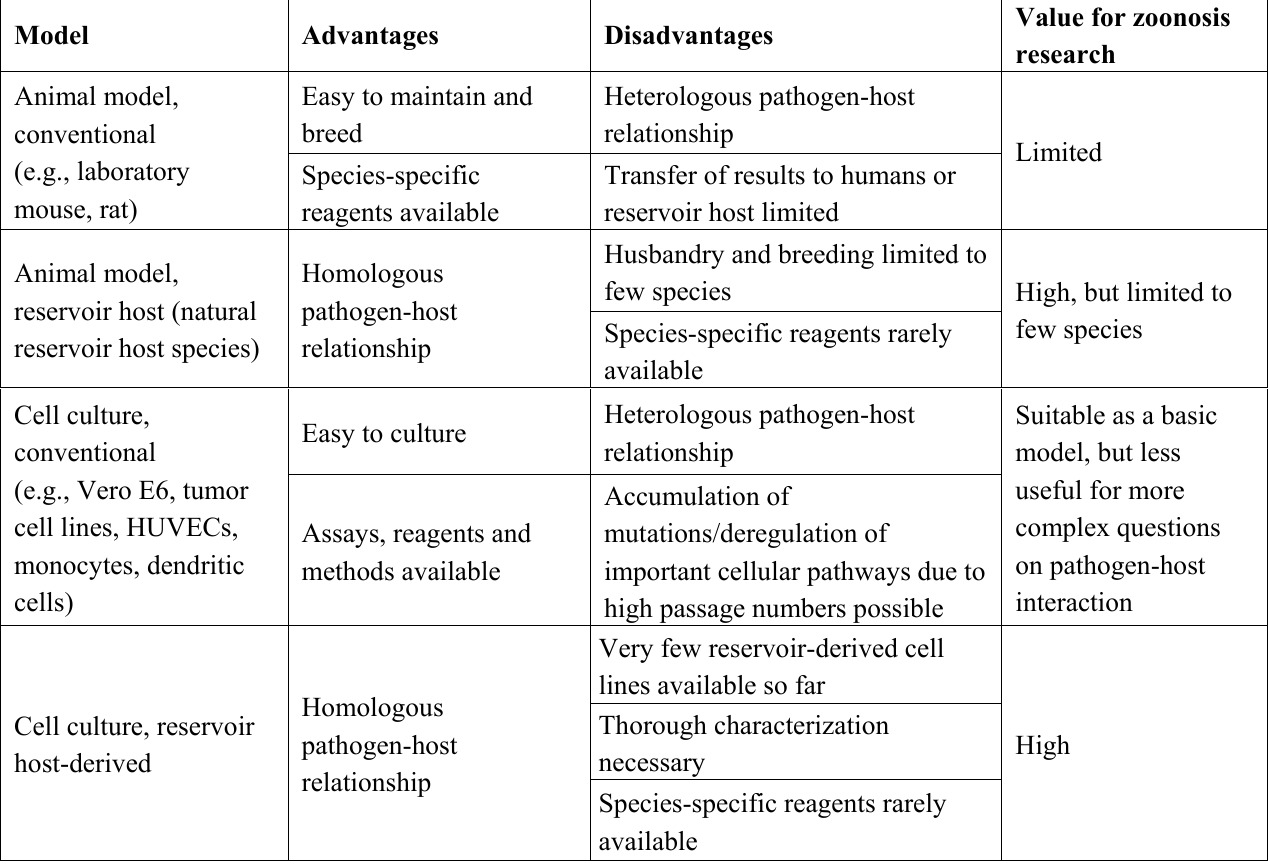
Table 1. Overview of model systems for the study of zoonotic